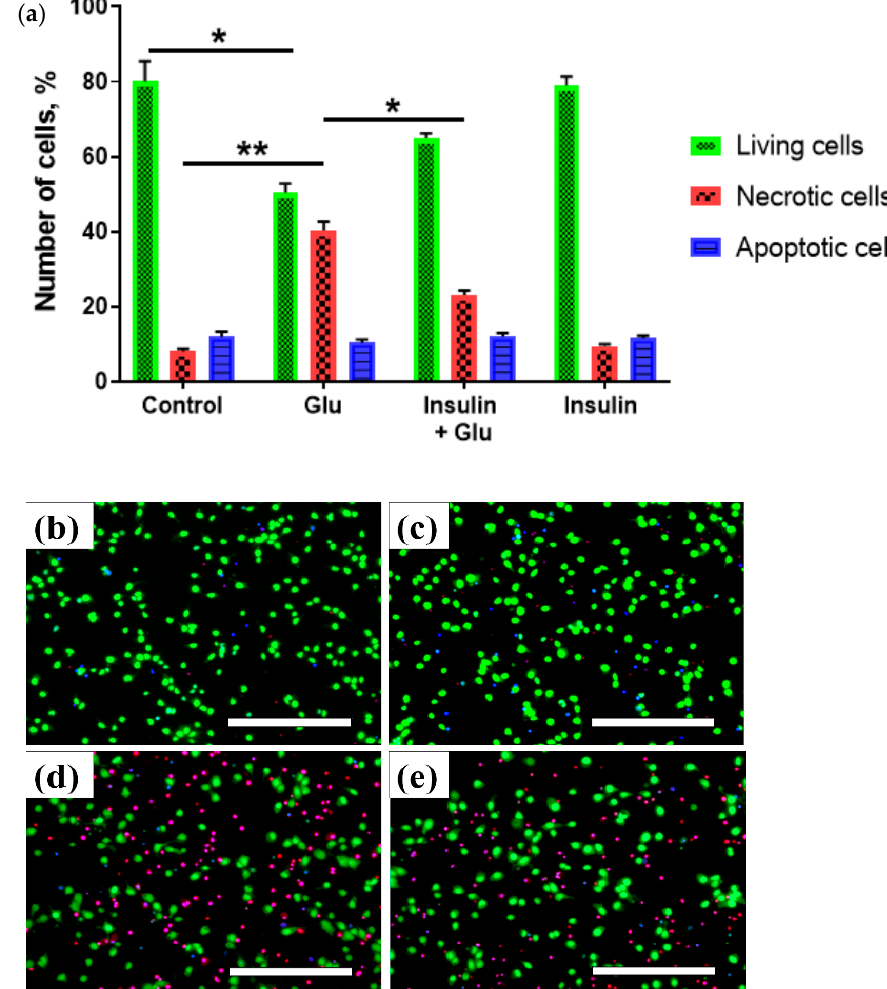
Figure 1. Insulin increases the proportion of living neurons and decreases the proportion of necrotic cells treated with the excitotoxic Glu dose. Proportion of cells ( a ) and fluorescent-microscopic photographs of the primary culture of rat cortical neurons one day after the excitotoxic action of glutamate ( b – e ). ( b ) control, ( c ) insulin, ( d ) glutamate, ( e ) glutamate with insulin. Cells were stained with vital fluorescent dyes (Syto-13, EthD-1, Hoechst-33342). Data are presented as M ± SEM. * p < 0.05; ** p < 0.001. The scale bar corresponds to 200 µm.